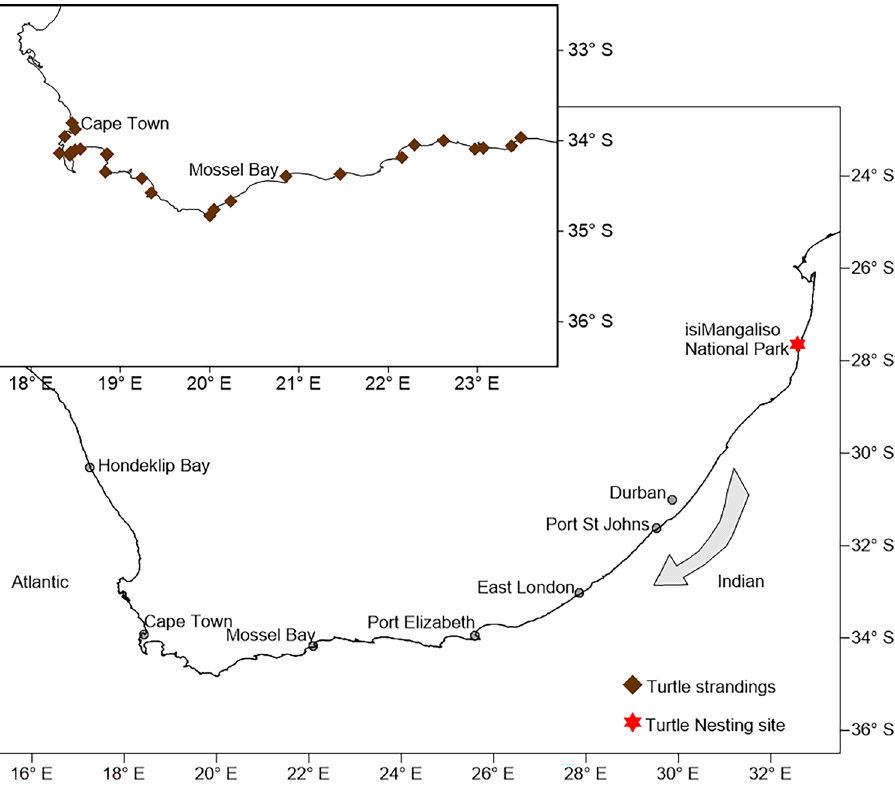
Figure 1. Map showing the South African coastline, indicating nesting sites and sites where post-hatchling sea turtles were found along the coastline between Mossel Bay and False